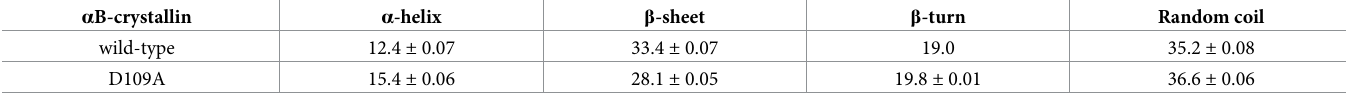
Table 1. The percentage of secondary structure content of different α B-crystallins obtained by the CD studies.